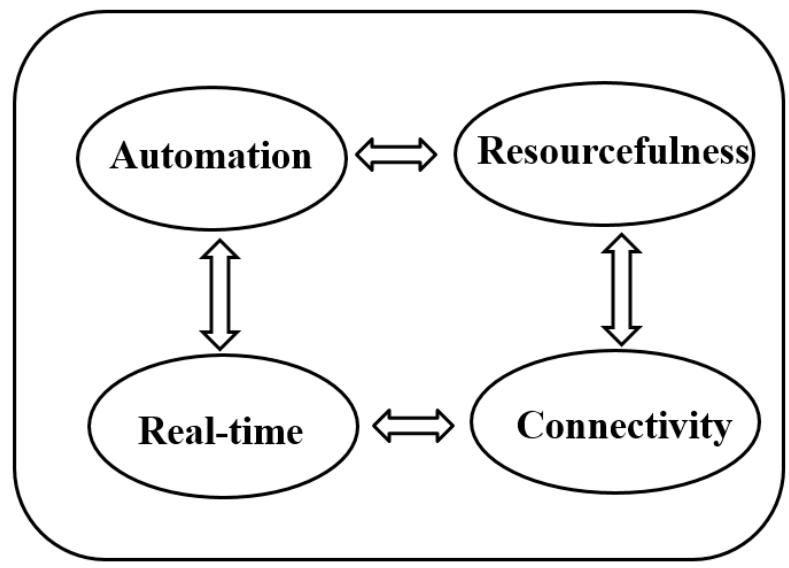
Figure 7. Property layer designing.